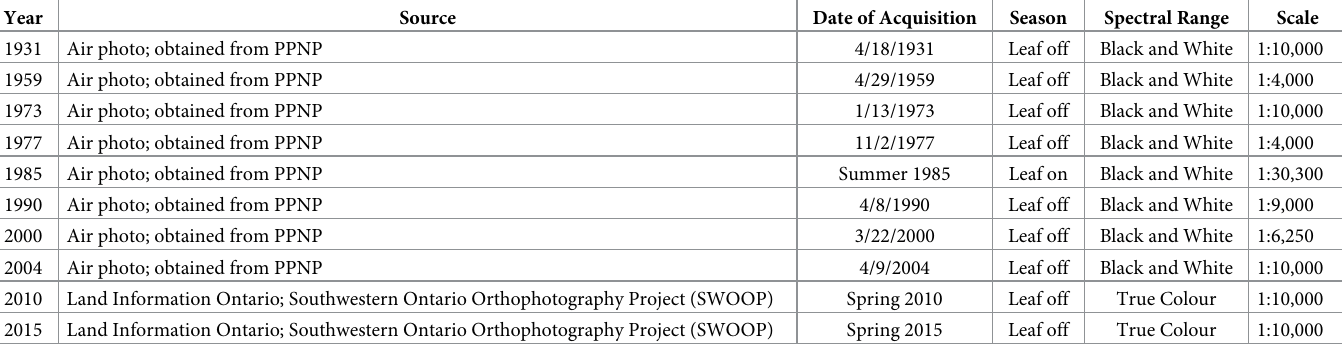
Table 1. Image data processed for change-detection analyses in Point Pelee National Park (PPNP).